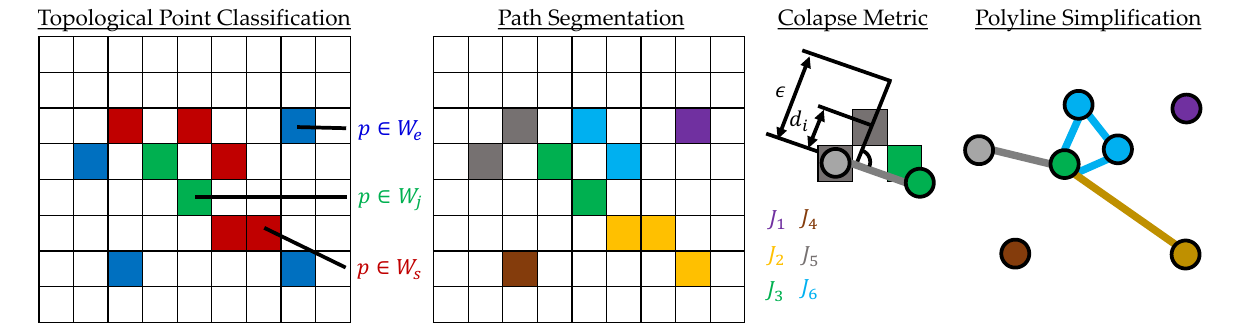
Figure 3. Polyline path estimation: topological segmentation of the skeleton, path segmentation, collapse metric for path simplification, simplified path as a polyline.